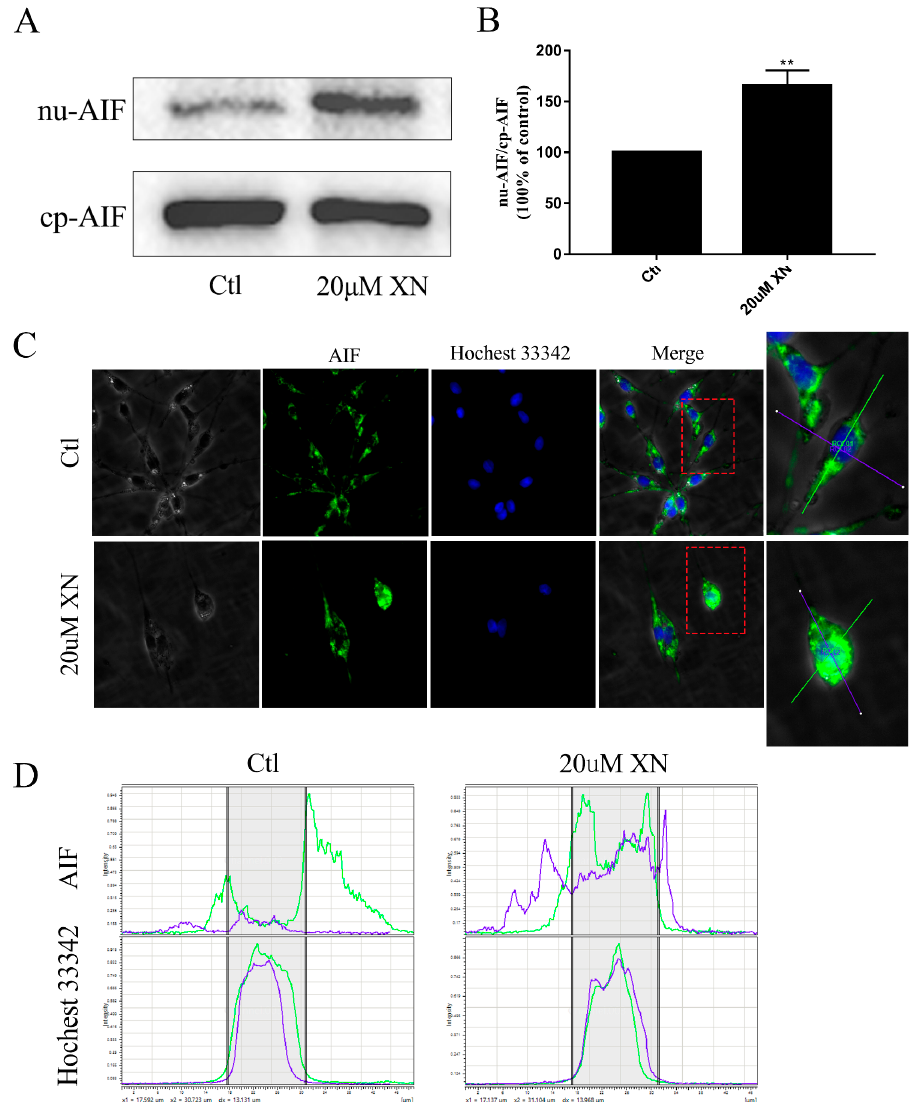
Figure 3. Effects of XN (20 uM) on intracellular localization of AIF. ( A , B ) The C6 cells were exposed to XN for 96 h. The levels of AIF in cytoplasm (cp-AIF) and nucleus (nu-AIF) were detected by WB. ( C , D ) Cells were treated with XN for 96 h, and then cells were subjected to immunocytochemistry using anti-AIF (green). Positioning was captured, and the fluorescence distribution was analyzed by a Leica Microsystems microscope (400 × g magnification). All data presented are the mean ± SEM from three independent experiments. ** p < 0.01 vs. control groups.